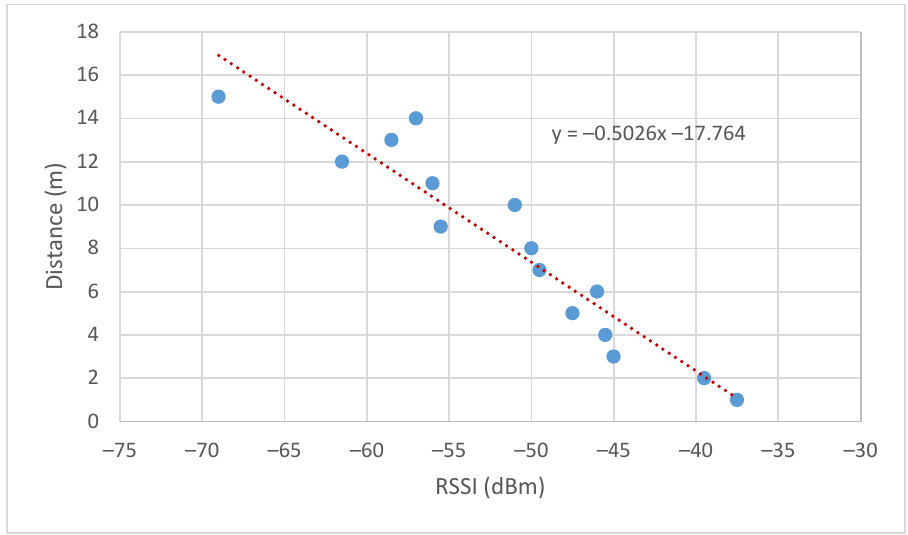
Figure 13. Received signal strength indicator (RSSI) vs. distance node 1. Sensors 2019 , 19 , x FOR PEER REVIEW